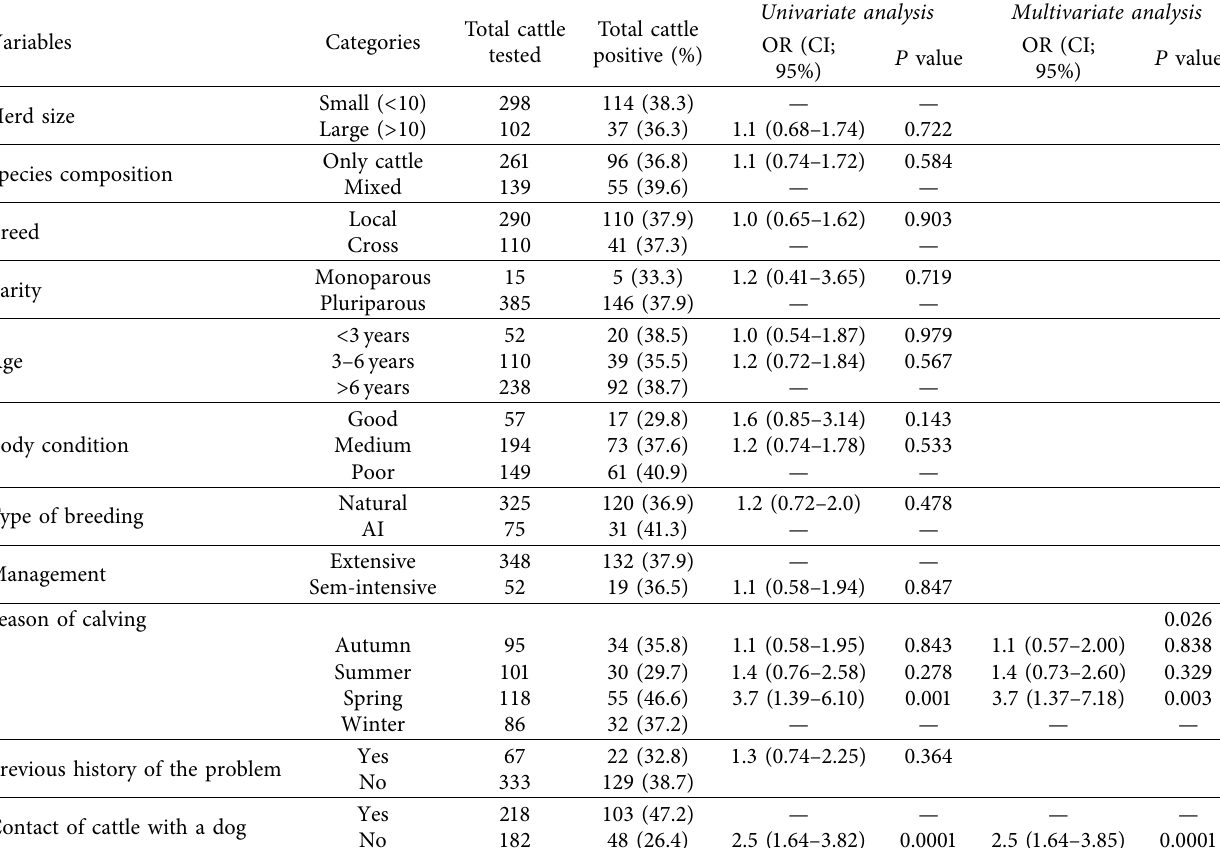
Table 2: Te efect of potential risk factors on the reproductive problems of cattle in the study area.